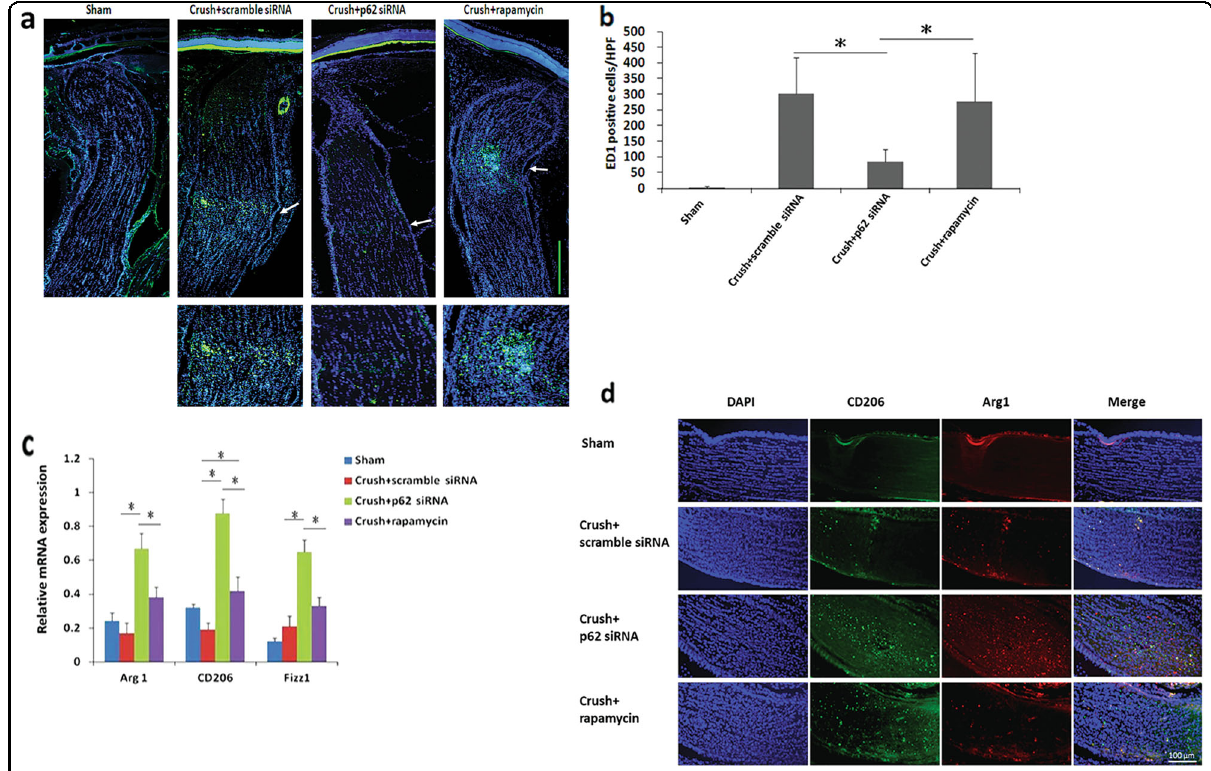
Fig. 4 Macrophage in fi ltration in the p62 siRNA-treated group was lower than that in the rapamycin-treated group 2 weeks after ONC. a Representative fi gures for ED1 staining in the longitudinal sections of the optic nerve. The ED1-positive cells (macrophages) in green were labeled with FITC, and the nuclei in blue were stained with DAPI. White arrows in the top panel are the crush site, magni fi ed images of the crush site are given below the corresponding panels ( b ) Quanti fi cation of ED1-positive cells/HPF. Data are expressed as the mean ± SD in each group ( n = 6). The macrophage recruitment in the p62 siRNA-treated group was reduced by 3.52-fold and 3.26-fold compared with that in the scrambled siRNA-treated group and rapamycin-treated group, respectively. c Evaluation of M2 macrophage polarization after autophagy inducer treatment in the ONC model. Relative mRNA expression levels of the markers of M2 macrophages in the optic nerves are shown as histograms. Each value was normalized to the reference gene, CypA. The expression levels of Arg 1, CD206, and Fizz1 (markers of M2 macrophages) were increased in the optic nerve after immediate treatment with p62 siRNA compared with those observed after treatment with scrambled siRNA or rapamycin. Treatment with rapamycin also induced CD206 expression, in contrast to treatment with scrambled siRNA. d Immunostaining of CD206 and Arg1 in the optic nerves at 2 weeks after ONC for evaluating M2 macrophage polarization. CD206 and Arg1 were highly expressed in the optic nerve following treatment with p62 siRNA compared with those observed following treatment with scrambled siRNA or rapamycin. * P <